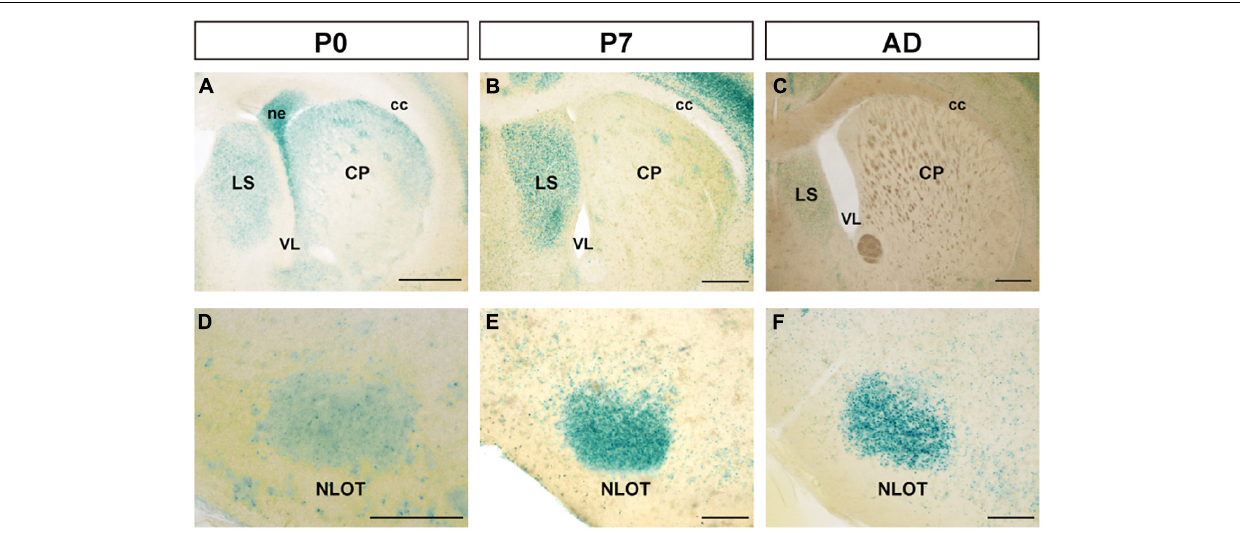
FIGURE 3 | Expression pattern in the caudate putamen (CP), lateral septal nucleus (LS), and nucleus of the lateral olfactory tract (NLOT) at P0, P7, and adult mouse. (A–C) In the caudate putamen (CP), FLRT2 signals decreased during development. Note that strong expression was observed in the neuroepithelium at P0 (A) and the lateral septum at P7 (B) . (D–F) In the nucleus of the lateral olfactory tract (NLOT), intermediate expression of FLRT2 was observed at P0 (D) , and high expression was observed at P7 (E) and adulthood (F) . cc, corpus callosum; CP, caudate putamen; LS, lateral septal nucleus; ne, neuroepithelium; NLOT, nucleus of the lateral olfactory tract; VL, lateral ventricle. Scale bars, 500 µ m (A–C) ; 200 µ m (D–F) . n = 3, 3, and 4 for P0, P7 and adulthood, respectively.